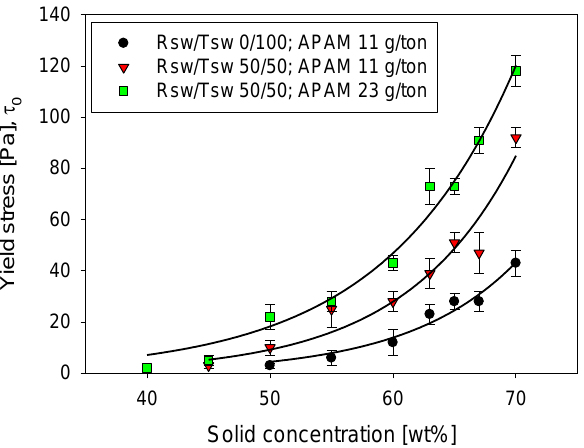
Figure 11. Yield stress of clay-based synthetic tailings (Tailings 1 with quartz/kaolin at 90/10 ratio) flocculated in a range of solid concentrations, using treated seawater (Tsw), and a 50/50 blend of raw seawater (Rsw) and Tsw (Msw).